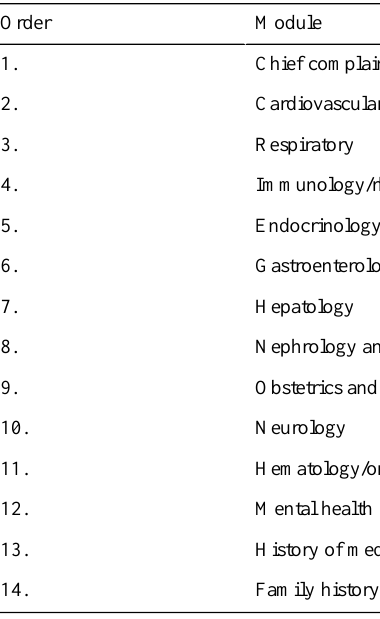
Table 1. Consecutive order of medical modules in the